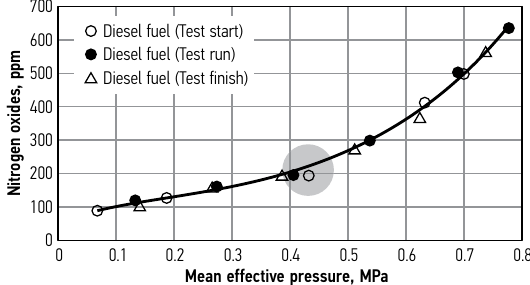
Fig. 5. The dependence of the nitrogen oxides (NO x ) emission of 1Z diesel engine on mean effective pressure P me when the engine runs on diesel